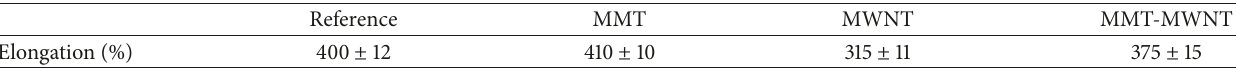
Table 2: Mechanical properties of the elastomer